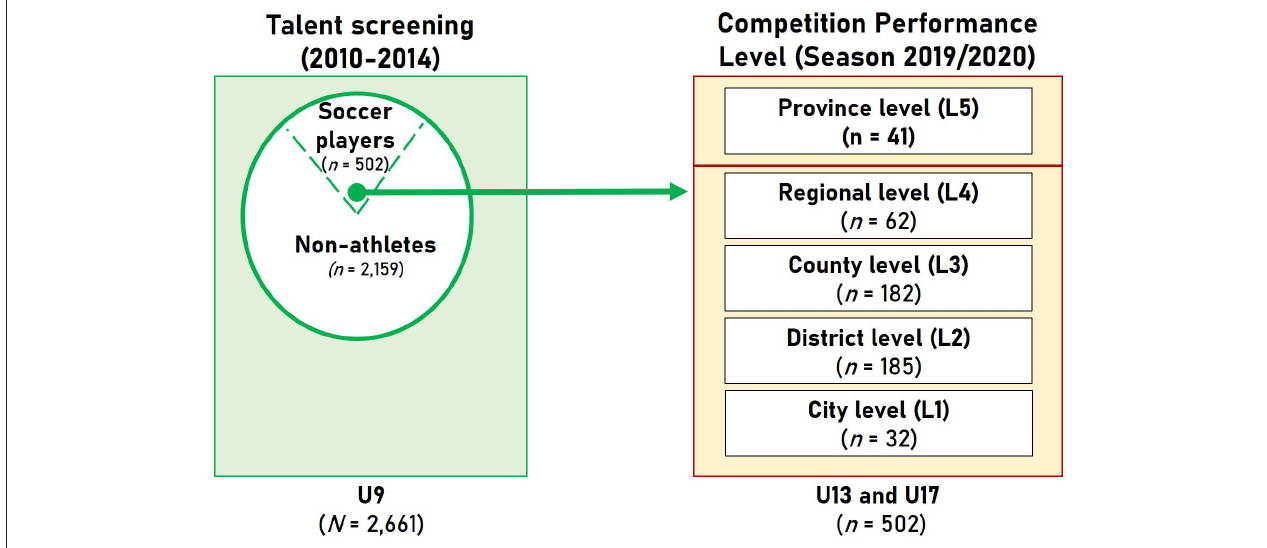
FIGURE 3 | Scheme of the participants’ groups of the talent screening campaign (2010–2014) included in this study.